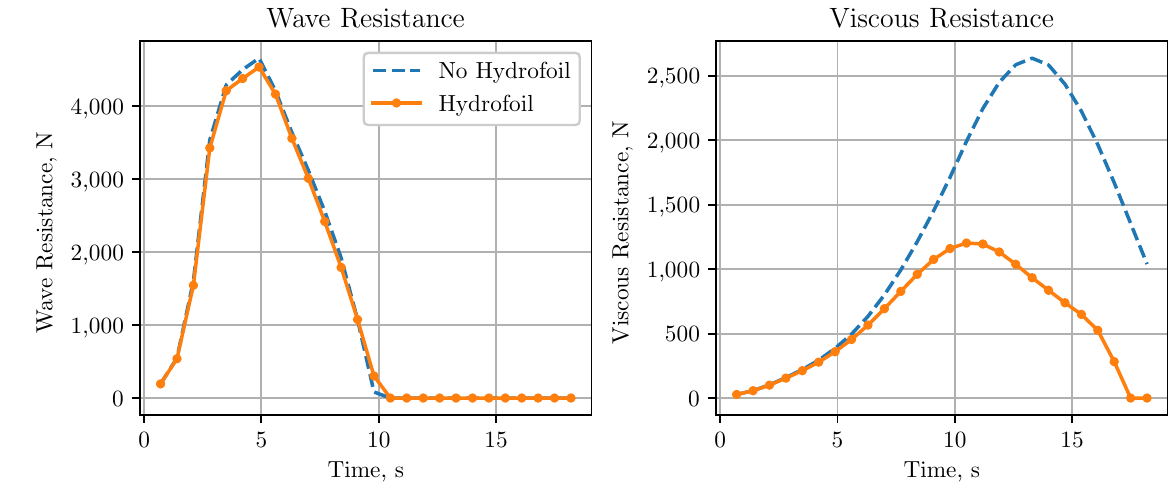
Figure 16. Hull resistance comparisons with and without the hydrofoil.